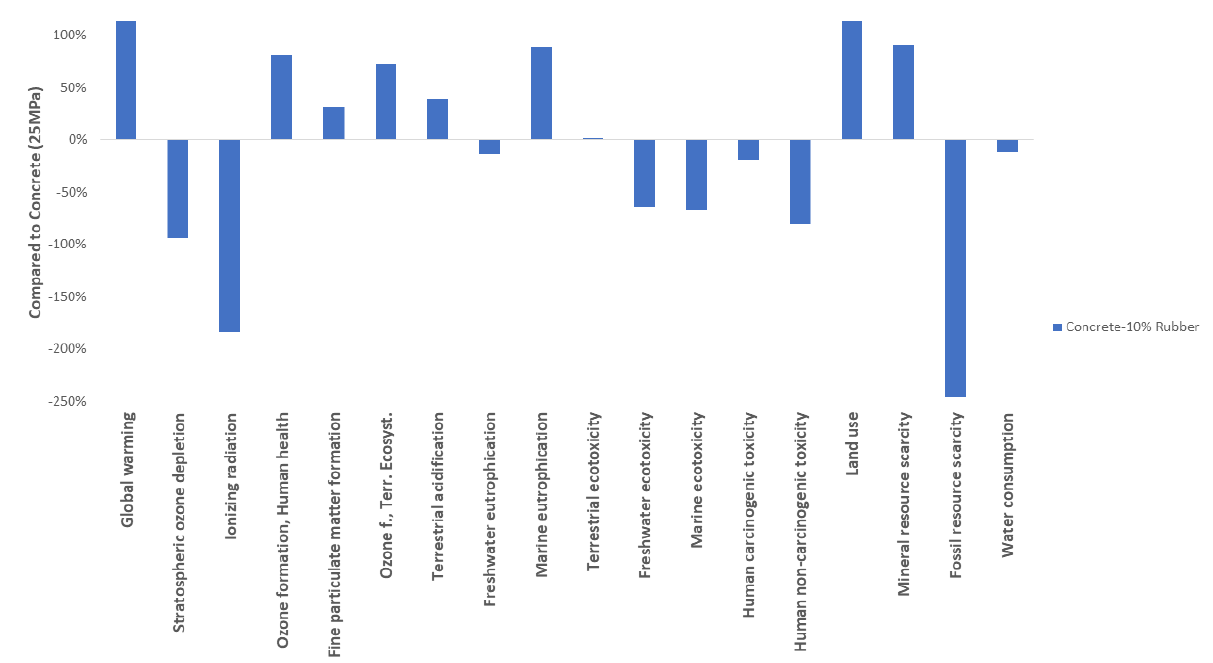
Figure 11. Percentual environmental impact of concrete that contains 10% of recycled rubber compared to 25 MPa Concrete.